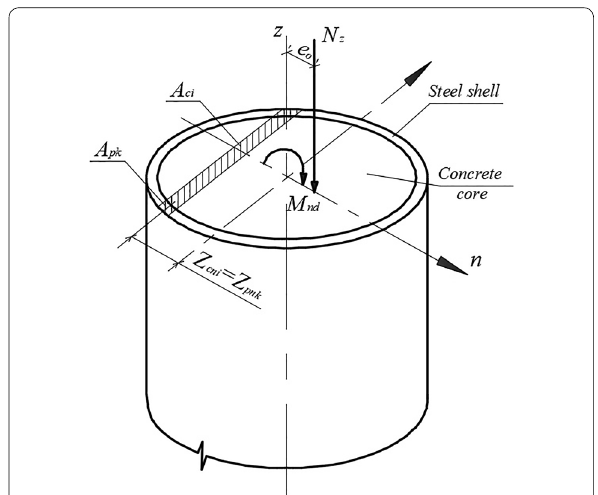
Fig. 4 Calculation scheme of the normal section CFTC.